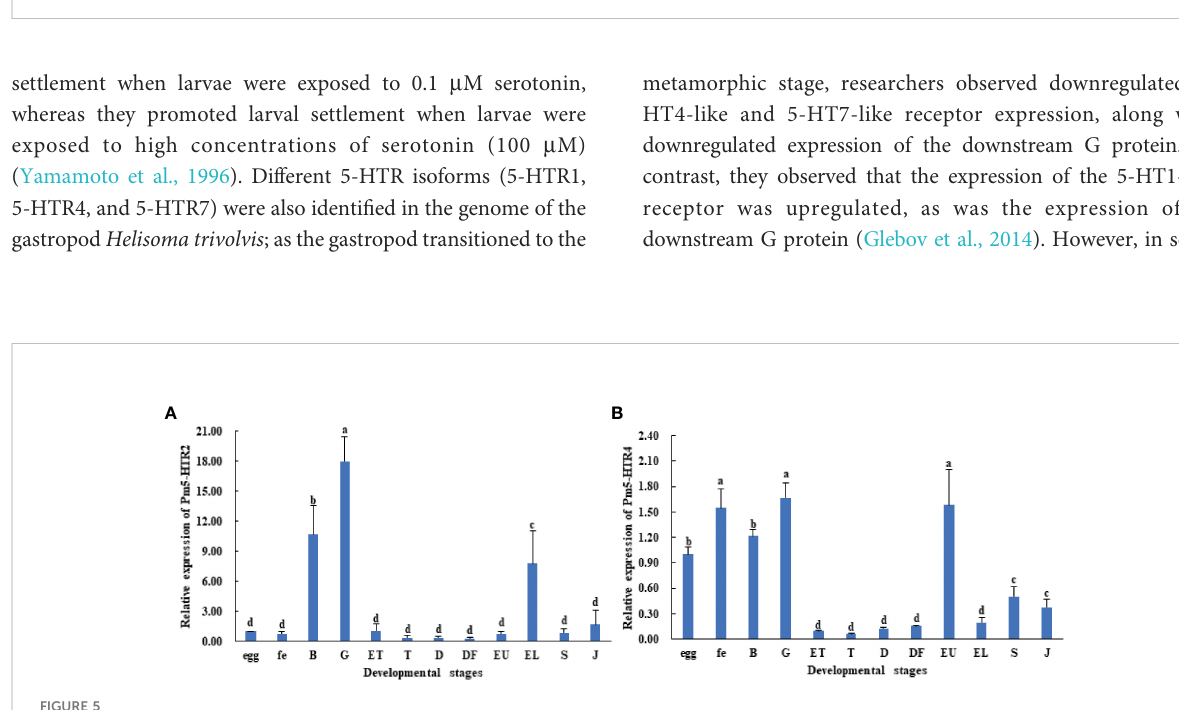
FIGURE 4 Phylogenetic tree analysis of Pm5-HTR2 and Pm5-HTR4 from different species. The phylogenetic tree was constructed by MEGA software 6.05 using the neighbor-joining method with 1000 bootstrap replications. The scale bar indicates a branch length of 0.1.